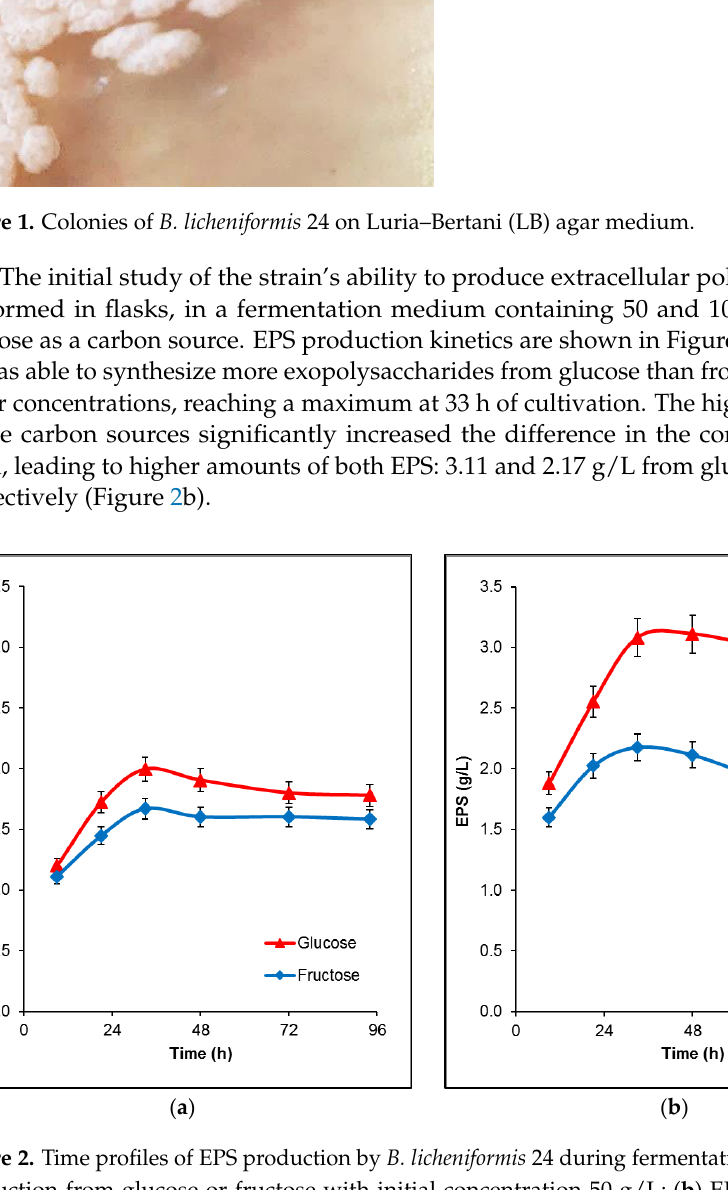
Figure 2. Time profiles of EPS production by B. licheniformis 24 during fermentation in flasks. ( a ) EPS production from glucose or fructose with initial concentration 50 g/L; ( b ) EPS production from glucose or fructose with initial concentration 100 g/L. The mean values from three independent cultivations are presented.